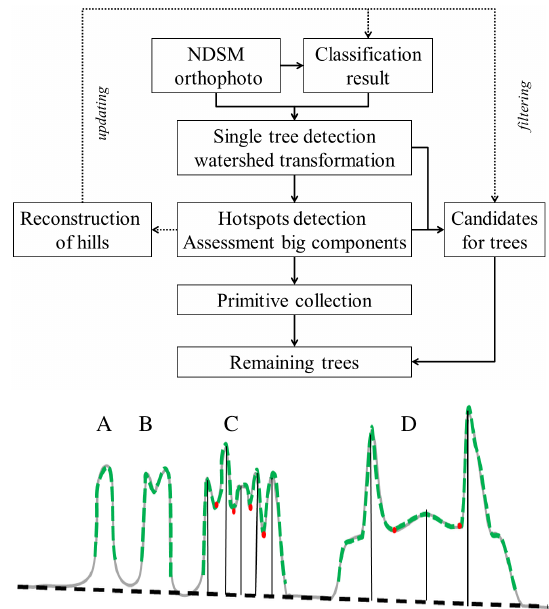
Figure 1: Top: overview of the algorithm with dotted lines de- picting correction of the anomalies. Bottom: Proof of principle for individual tree detection with watershed. The height profile for DSM and DTM are shown by solid grey curve and dashed black curve, respectively. The result of classification is depicted by a thick solid green line while centers and borders of different watershed components are shown by vertical black lines and red points,